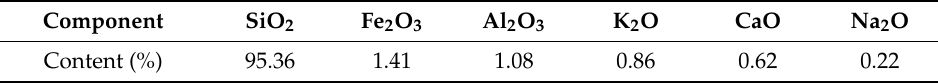
Table 2. The main chemical composition of